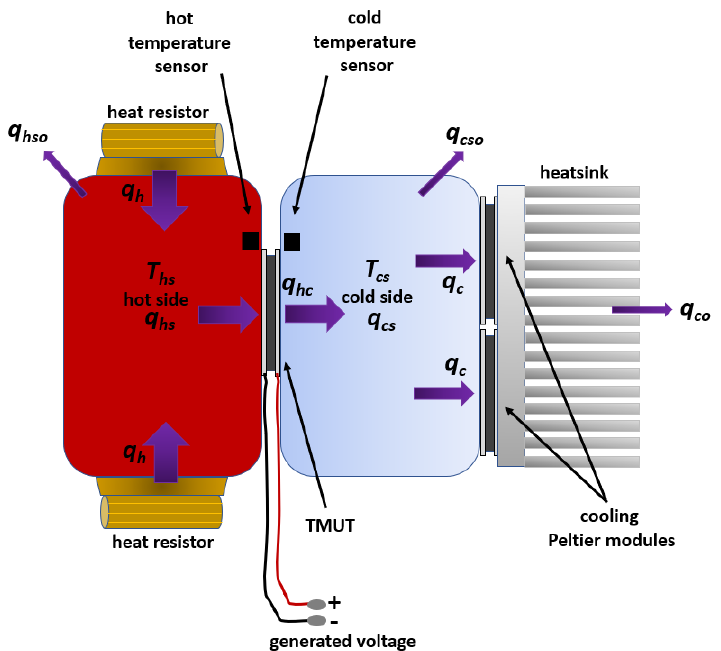
Figure 6. Schematic of the heat flow from the heat resistors, through the hot and cold sides, as well as the Peltier element, and out of the system by means of the